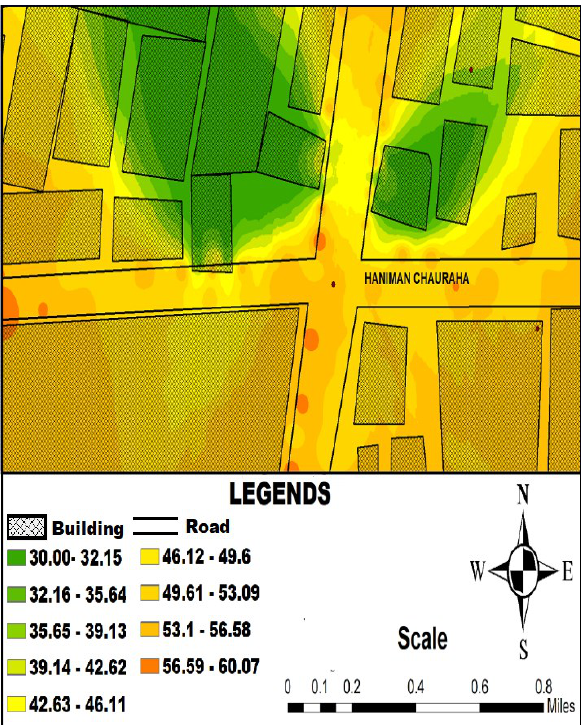
Figure 7. The noise map of Haniman Chauraha of the morning slot with value variation is between 30.00 to 56.63. Barrier and distance attenuation is also calculated and mapped. The afternoon slot for Haniman Chauraha noise map has shown in Figure 8.